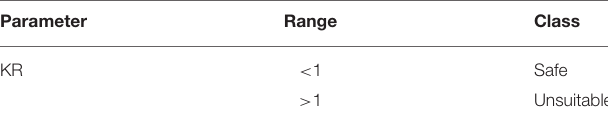
Source: Todd (1980).